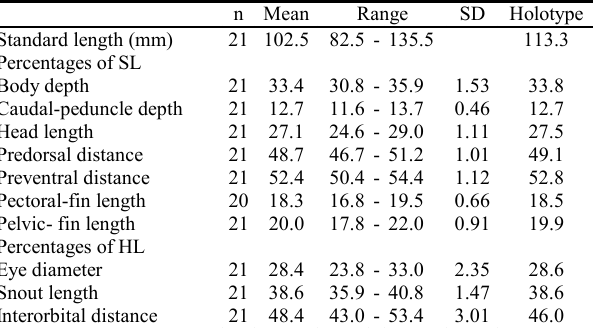
Table 1. Morphometric data of Leporinus venerei